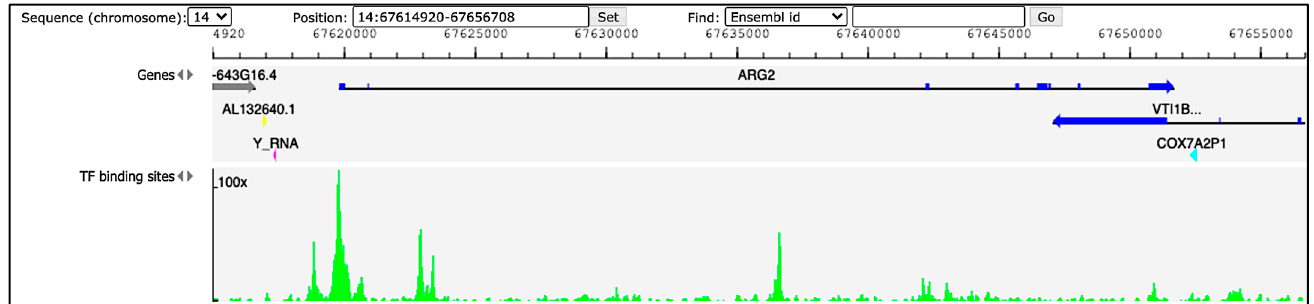
Figure 1. Peaks of TF binding sites from GTRD (http://gtrd.biouml.org, v20.06, accessed on 31 August 2021). The tracks in the diagram indicate genes and TF binding sites. Dark-blue segments in the ARG2 gene correspond to the exons. The green histograms refer to DNA footprint peaks corresponding to the TF binding sites in the region chr14:67,614,920–67,656,708.